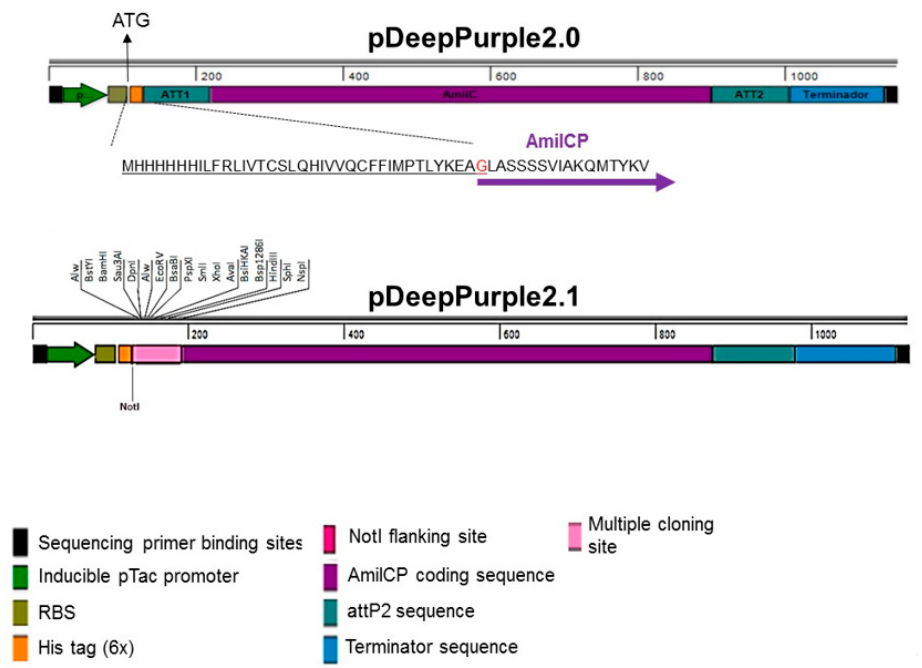
Figure 4. Protein expression cassette map. Original plasmid cassette containing the modified attP1 for in-frame protein expression. The protein sequence is shown for the modified N-terminal portion of AmilCP.